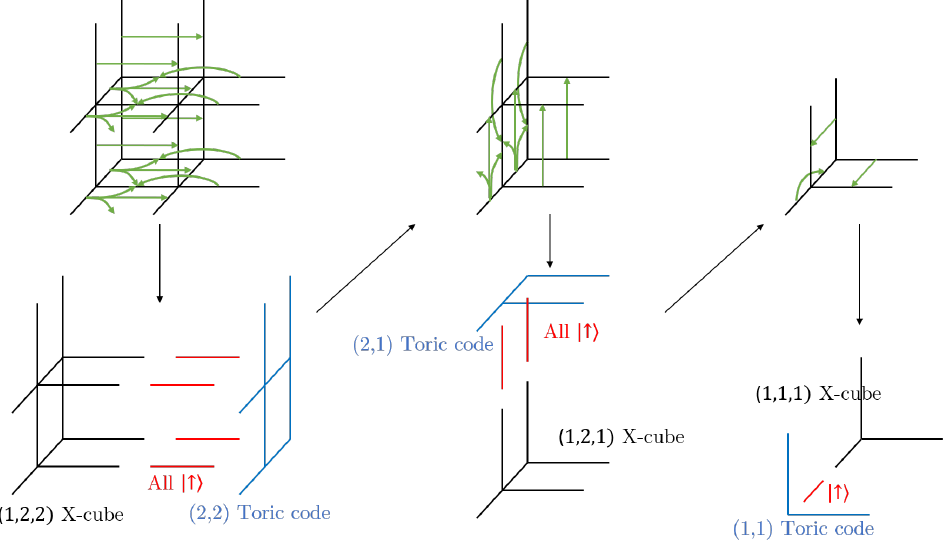
Figure 8: The unitary transformation to reach the minimal structure of the X-cube model on T 3 . The arrows denote CNOT gates going from the control qubit to the target qubit, and one can verify that all the CNOT gates in each picture commute. Note that all the X-cube models and exfoliated toric codes at each step have periodic boundaries, so some of the CNOT arrows which seemingly do not point to any link actually point to the link on the other side of the